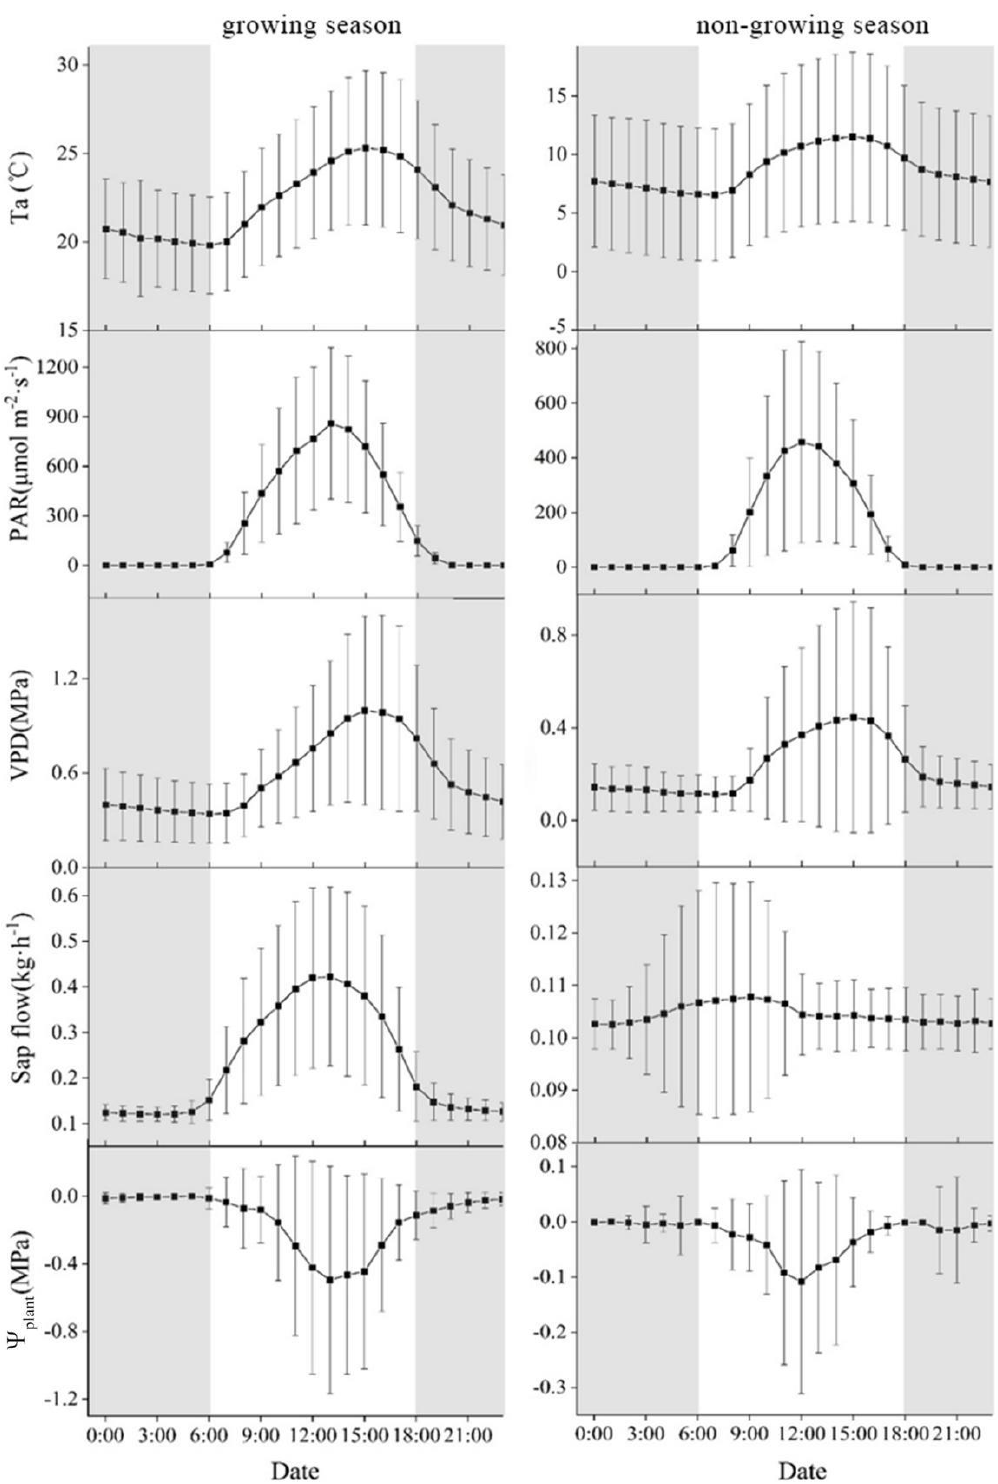
Figure 5. Diurnal variation in sap flow and environmental factors in growing and non-growing seasons during the whole study period. From top to bottom are temperature (Ta), photosynthetically active radiation (PAR), saturated water pressure difference (VPD), sap flow and plant water potential ( Ψ plant ). The left side of the figure represents the growing season, and the right side is the non-growing season. The gray shaded area in the figure represents night, and the white area represents day. All values are mean ± SD. The significance level was p < 0.05.